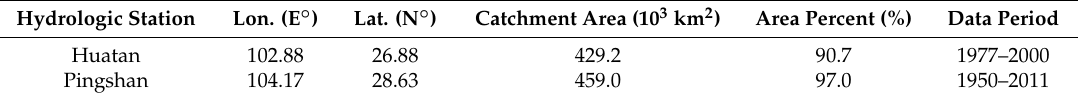
Table 1. Basic information of the two hydrologic stations.